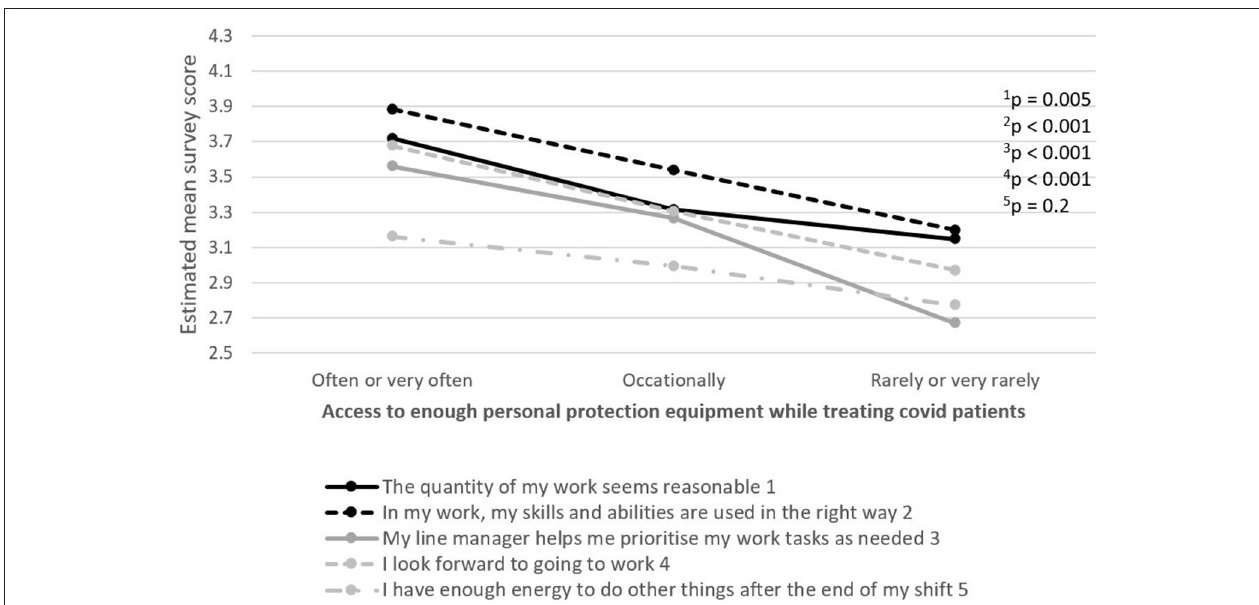
FIGURE 5 | The relationship between five selected work environment items in terms of job demands and resources, motivation and possibility for recovery, and lacking access to enough personal protection equipment while working with patients with COVID-19. The item’s survey score ranges between 1 (strongly disagree) and 5 (strongly agree).